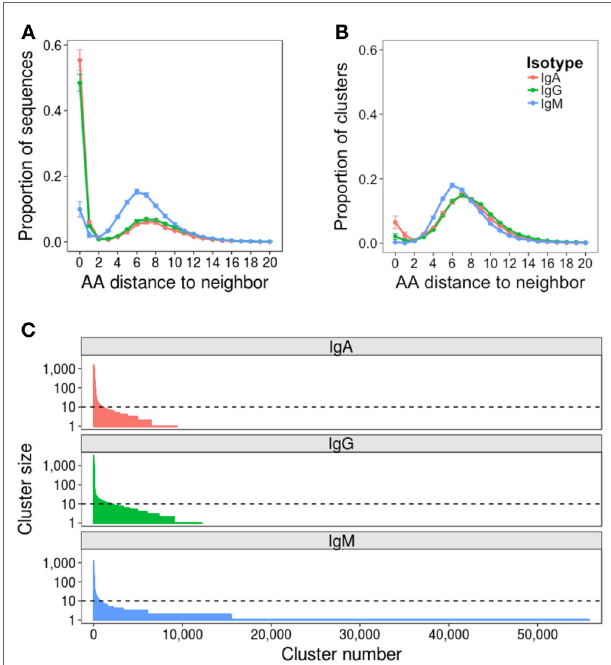
FigUre 2 | effect of clustering on the dataset . Nearest neighbor distributions of sequences both before (a) and after (B) clustering. Before clustering, CDR3 AA sequences are used, and after clustering, the cluster center AA sequence is used. The nearest neighbor of each sequence in each dataset is determined by comparing it to every other sequence of the same length in the dataset to find the closest match – that is its nearest neighbor. The distance is then the number of AA difference between the sequence and its nearest neighbor. Distributions were calculated from samples from all 10 participants, and mean ± SEM values plotted. (c) Clusters are ordered according to size, and the size of each cluster plotted. Representative data from one sample is shown (participant AF01, day 0). Horizontal dotted line intersects the y -axis at 10 sequences (0.01% of the total sequenced repertoire), and represents the cutoff between rare and abundant